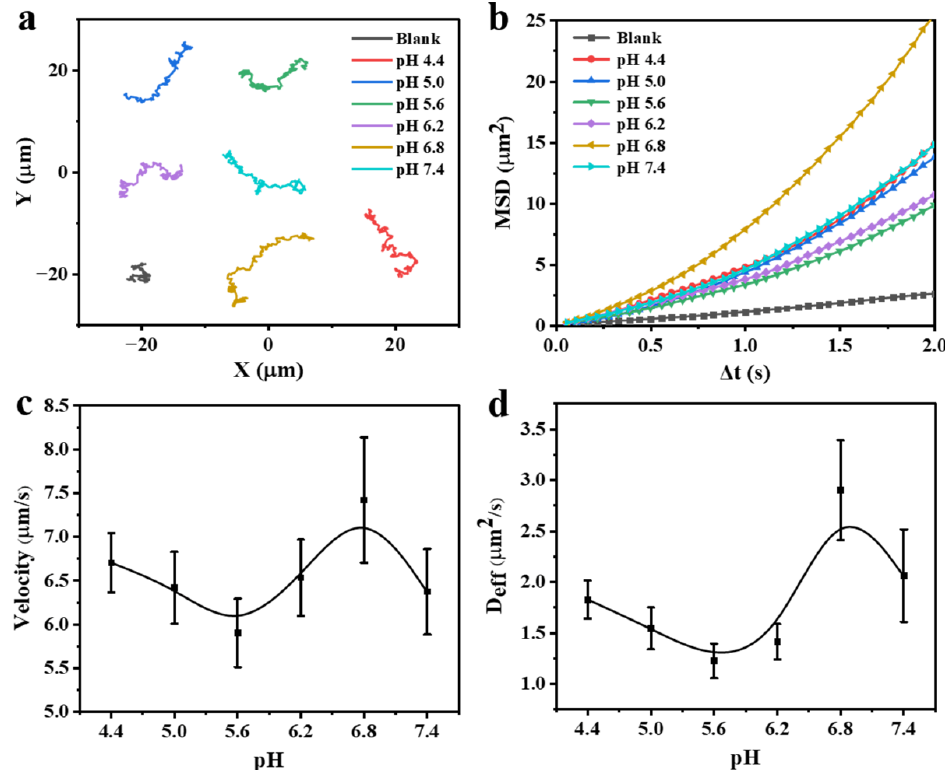
Figure 3. Motion analysis of the FCNMs at different pH values in 2.5 wt% H 2 O 2 aqueous solution. ( a ) Track trajectories of the autonomous motion of the FCNMs in 10 s. ( b ) MSD curves versus Δ t , ( c ) corresponding average velocities, and ( d ) average diffusion coefficients of the FCNMs.